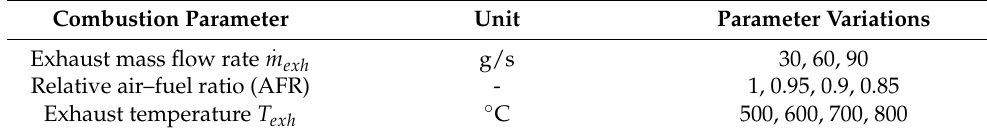
Table 6. Parameter variations.